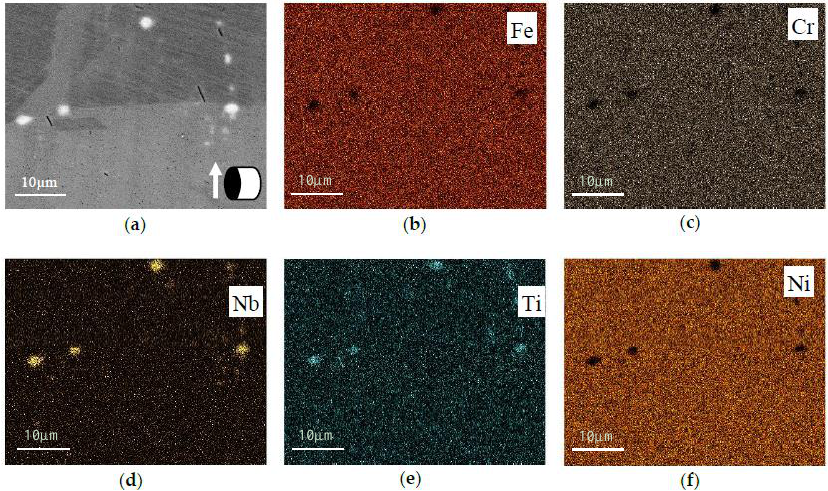
Figure 16. EDS elemental maps in the selected area ( a ) for Nb, Ti, Cr, Fe; and Ni ( b – f ), respectively.